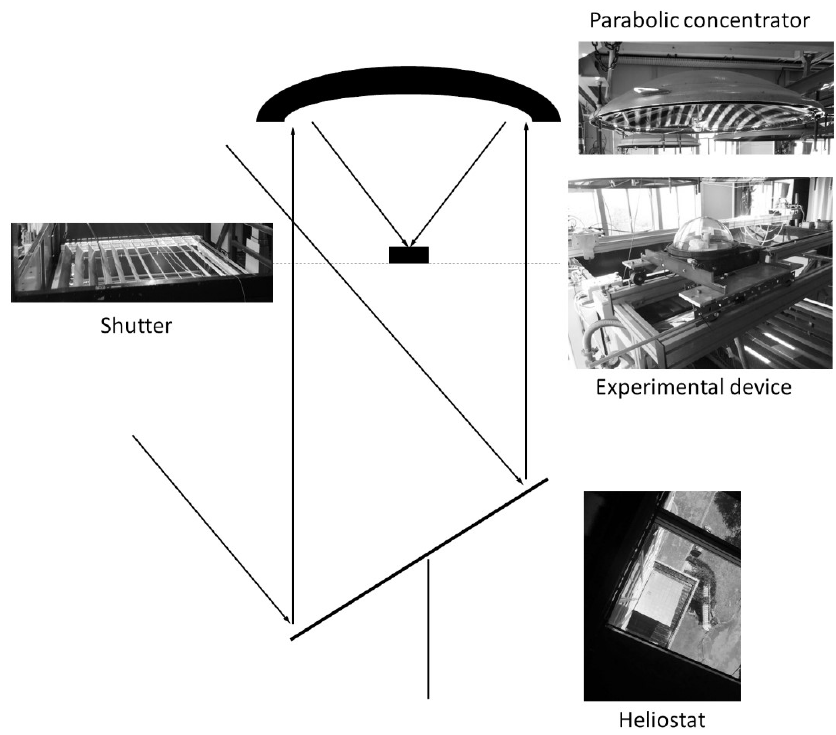
Figure 3. Scheme of the equipment used in the experiments.